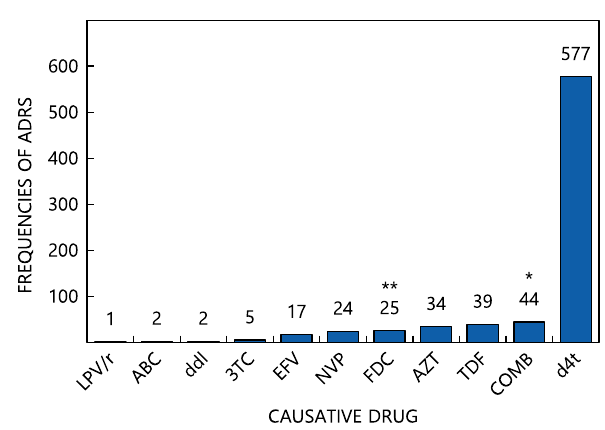
Figure 2: Frequencies of adverse drug reactions associated with drug causality.